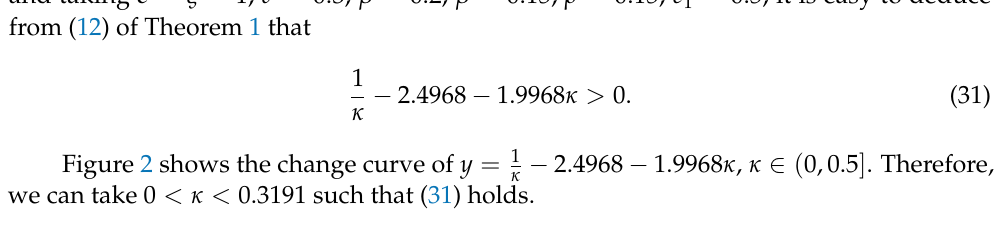
− 2.4968 − 1.9968 κ , κ ∈ ( 0, 0.5 ] . Therefore, κ